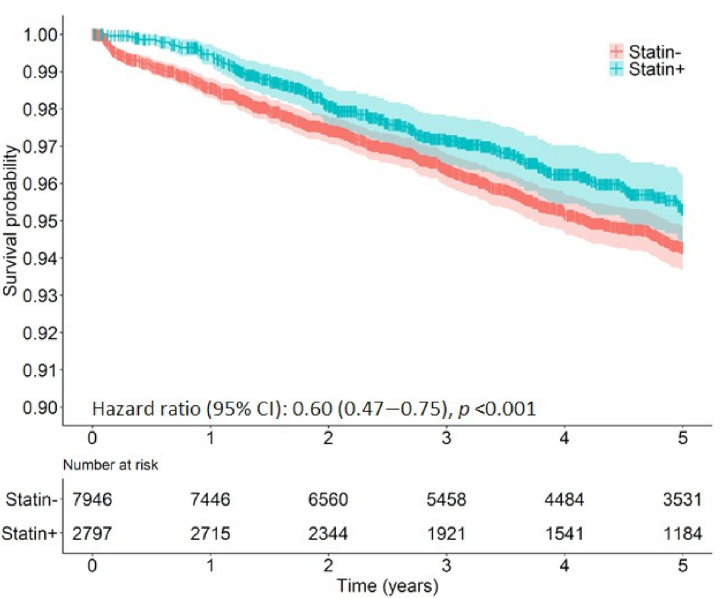
Figure 2. Kaplan–Meier plot of 5-year cancer-specific mortality for statin users and non-users following surgical resection for rectal